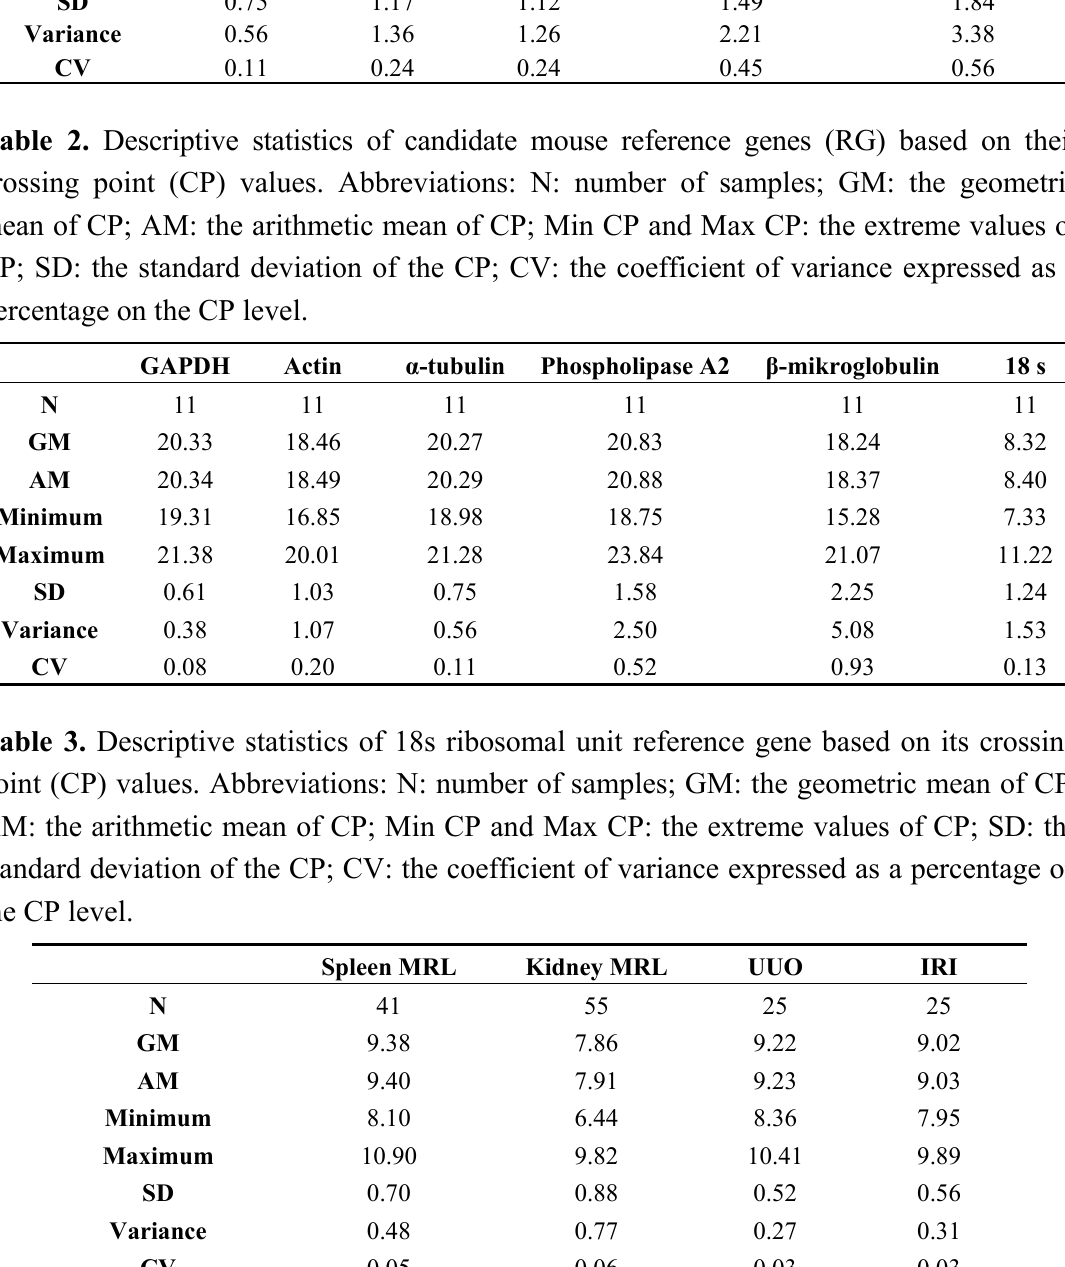
Table 2. Descriptive statistics of candidate mouse reference genes (RG) based on their